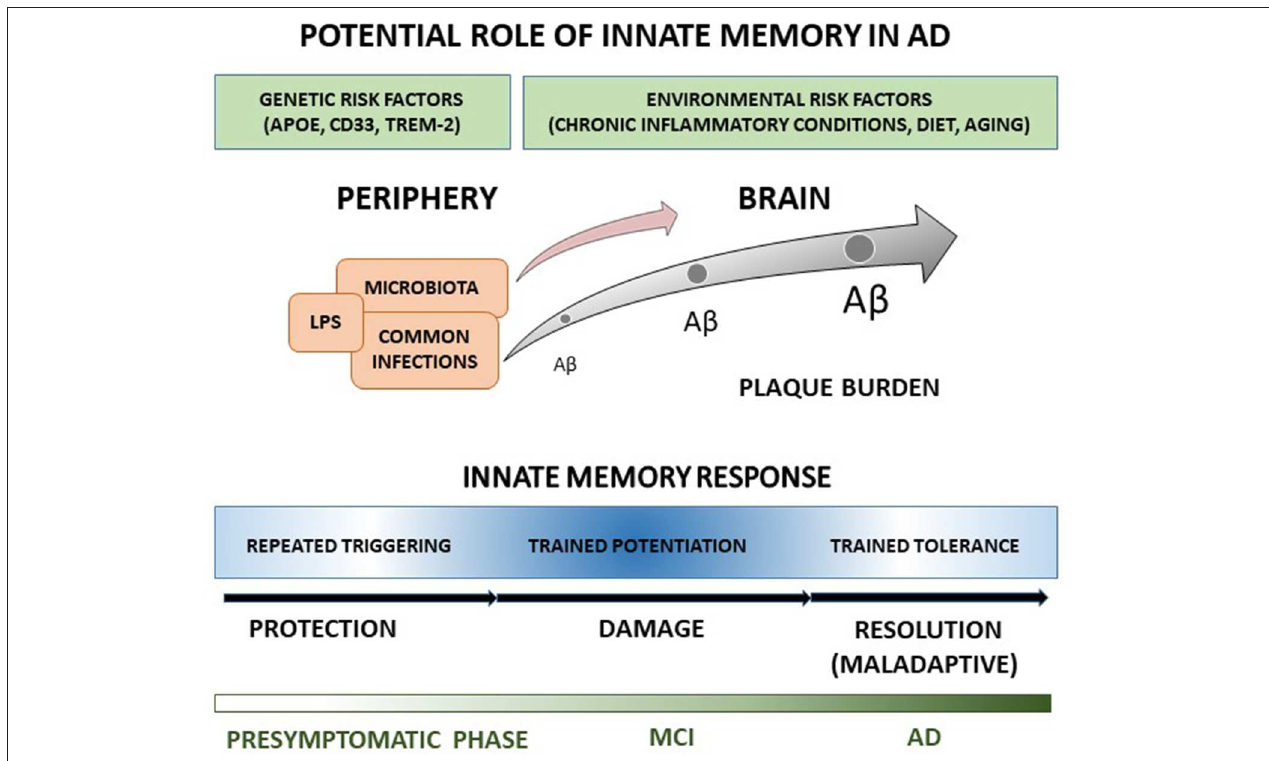
FIGURE 1 | The cartoon recapitulates our view of the potential role in AD of innate memory processes occurring during disease progression. A detailed explanation of the drawing is reported in the text.